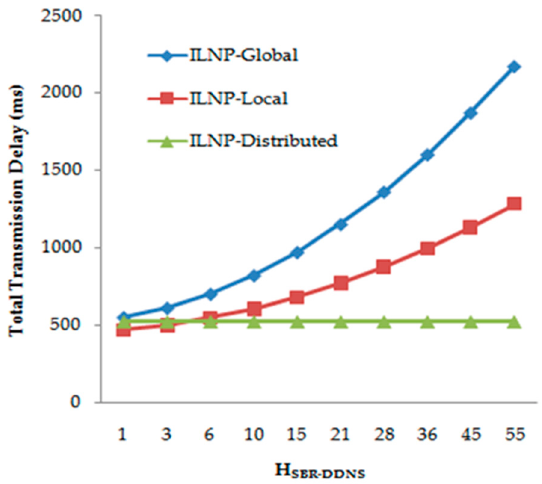
Figure 16. Impact of H SBR-DDNS on TTD.